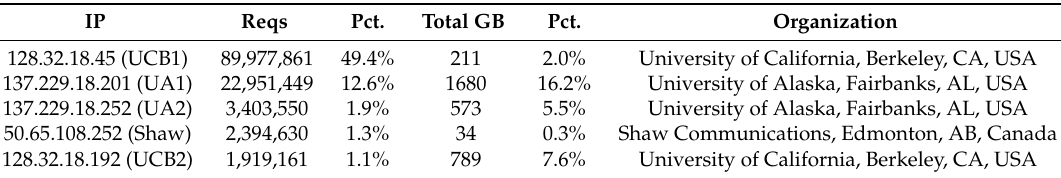
Table 4. Top five most frequently observed IP addresses.